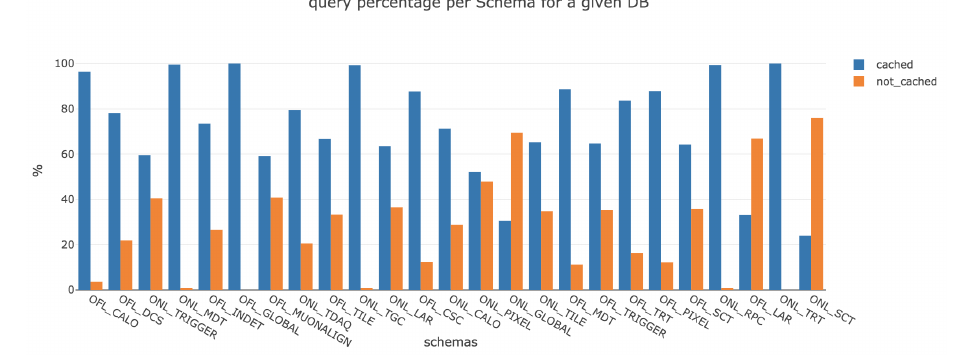
Figure 4. Visualization of data on https: // frontier.uc.ssl-hep.org. The percentage of the queries (cached vs. not-cached) per COOL data schema.